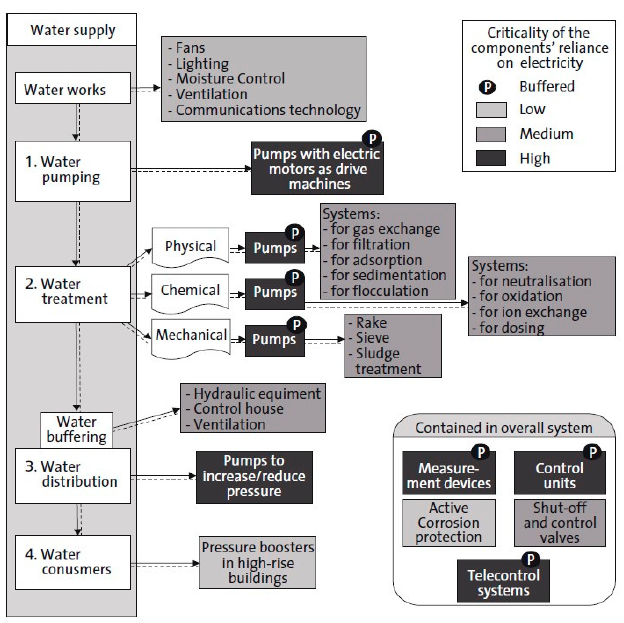
Figure 1. Technical elements in the water supply and their dependence on electricity [3].